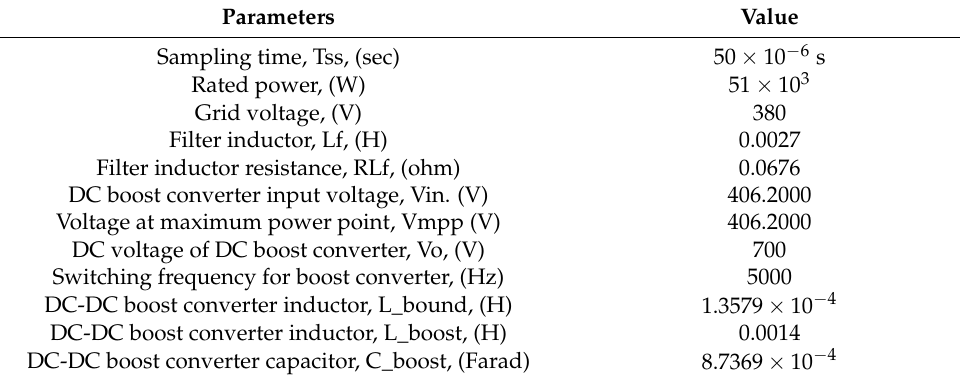
Table 3. Solar photovoltaic system configurations.